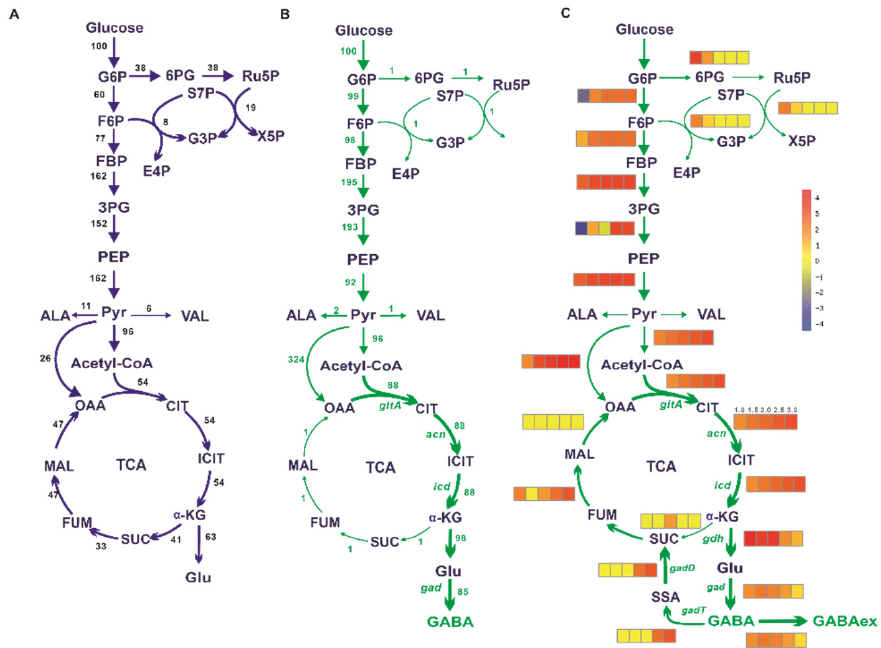
Figure 1. In silico simulation of the metabolic flux distribution in the WT strain and GABA overproducer by flux balance analysis. ( A ) The metabolic flux distribution in the WT strain. ( B ) The metabolic flux distribution in the GABA overproducer. The values are the respective flux to the glucose uptake rate. ( C ) The impacts of increased ACN reaction flux on intracellular metabolic flux by FBA using GABA exporter as the objective function with 20% biomass of theoretical maximum constraint. The ACN reaction flux was set to 1.0, 1.5, 2.0, 2.5, and 3.0 (from left to right) -fold compared to those in the WT strain, respectively. The corresponding changes in fluxes are shown with a heatmap of individual reaction using the normalized value. The different color represents the degree of flux changes. Yellow represents no change, red represents the increase in the flux, and blue indicates the flux toward the inverse direction as represented by the arrow.